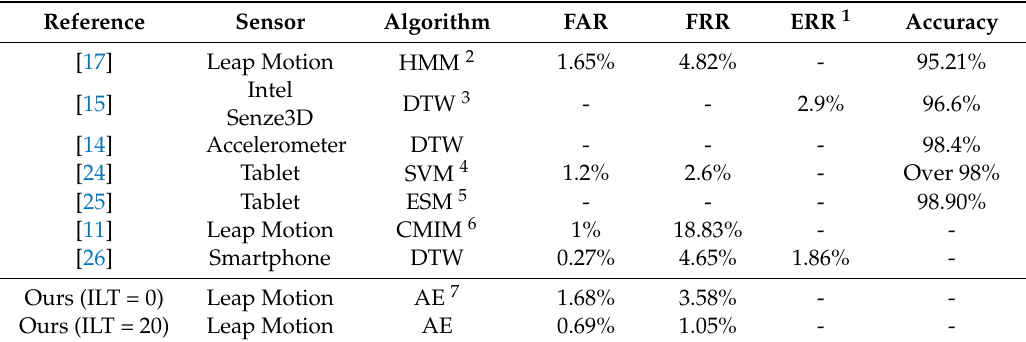
Table 4. Comparison of previous work to our approach.